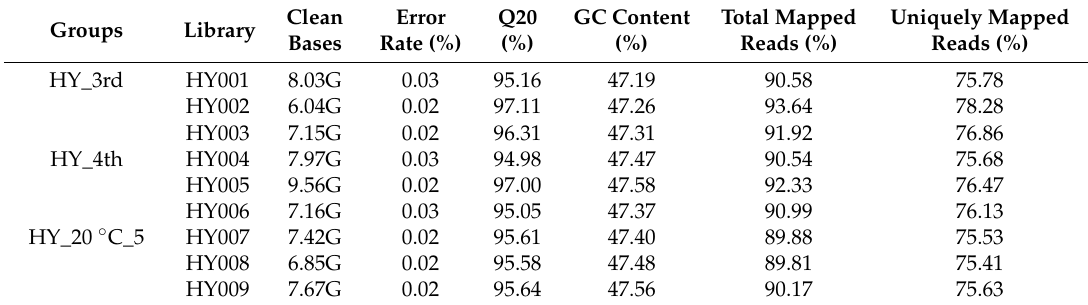
Table 1. Statistics of deferential gene expression (DGE) library sequencing and read